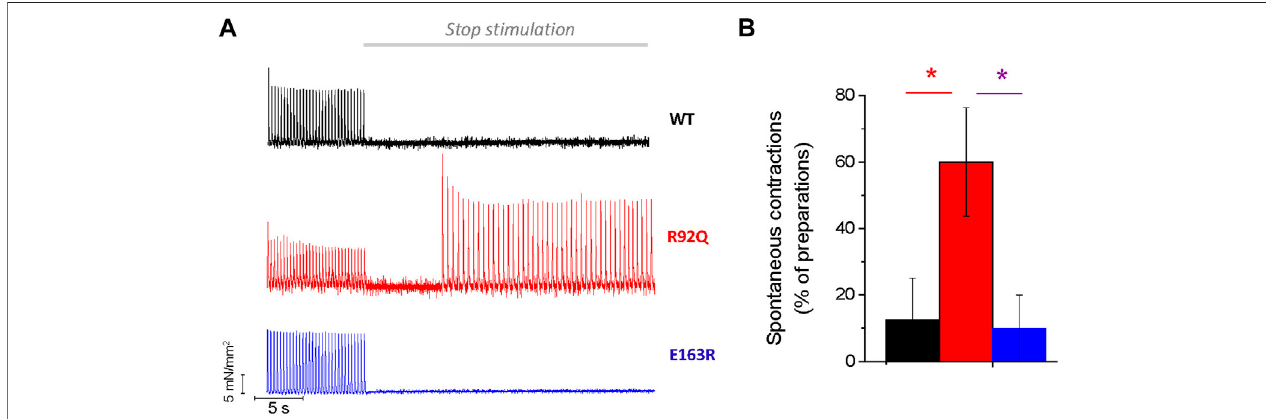
FIGURE5| Spontaneousactivity inR92Qatrial trabeculae. (A) Representativetraces showingthe stimulation protocolthatmay induce spontaneousactivity upon stimulation pauses following a train of high frequency stimuli. R92Q but not E163R and WT trabeculae showed signi fi cant occurrence of spontaneous triggered activity duringtherestingpauses. (B) Percentageoftrabeculaeshowingspontaneousactivityduringlongpauses.One-wayANOVAwithTukeycorrection.*= p < 0.05.WT(N= 9, n = 14), R92Q (N = 4, n = 10) and E163R (N = 5, n = 10) mice. N = number of animals, n = number of trabeculae.